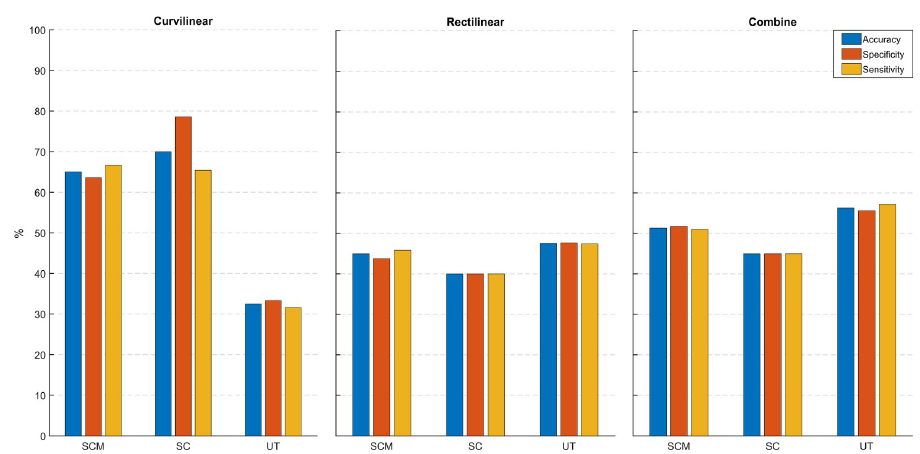
Fig 5. Classification performance for each gait trajectory for each muscle.